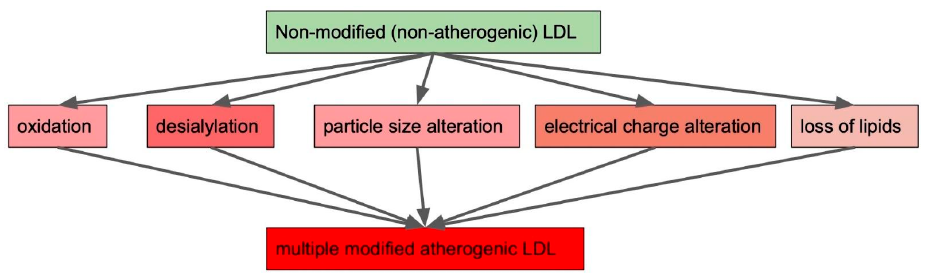
Figure 1. Possible modifications leading to the appearance of multiple modified low-density lipopro- teins (LDLs) possessing atherogenic